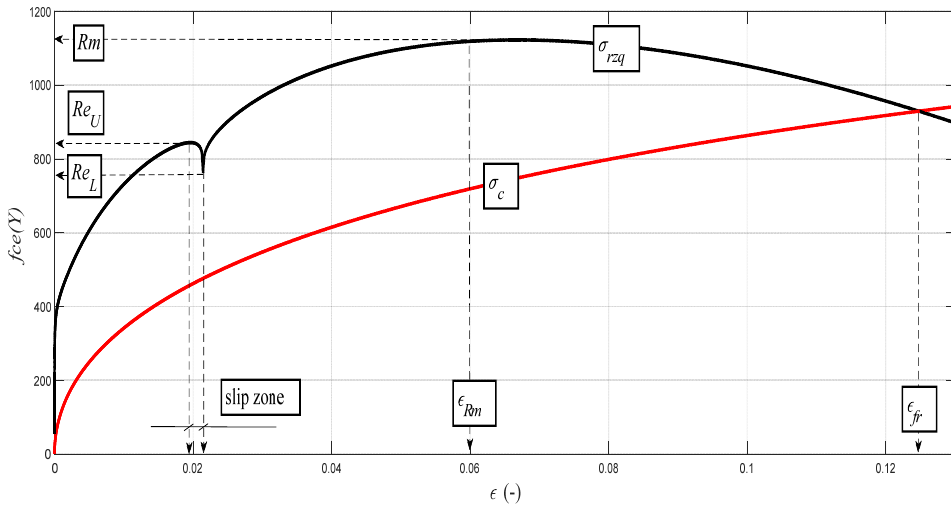
Figure 13. Analytical deformability diagram for the steel grade 15230QT for the dependence σ rzq = f ( ε ); detail for Re U and Re L . σ rzq (black color) and σ c (red color).